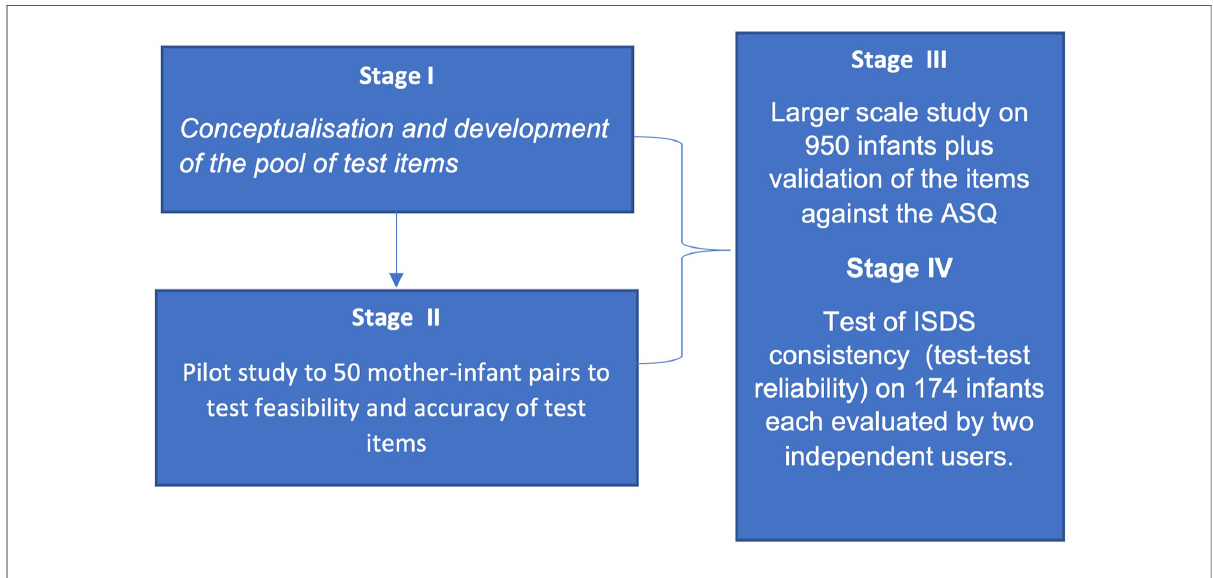
FIGURE 1 Flow chart for the development of screening tool.